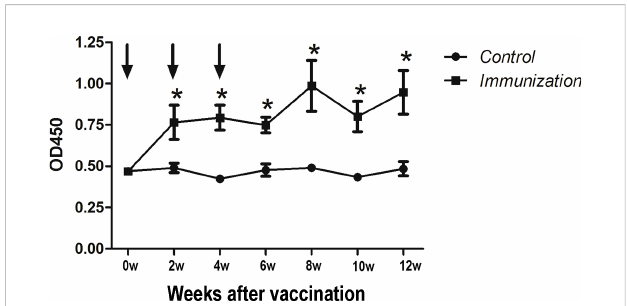
FIGURE 1 Mean (± SEM) of the serum antibody titers in the gonadotropin- releasing hormone (GnRH) immunization group (n = 35) and control group (n = 35). The ordinate is the OD of the serum GnRH antibody. The abscissa is the age of weeks after fi rst immunization and Arrows indicate the primary vaccination and subsequent boosters. * Indicates a signi fi cant difference ( P < cytometry. Figure 4A shows the gating strategy. Within 6 weeks after the fi rst immunization, the percentage of CD3+CD19- lymphocytes in the immunized group was signi fi cantly lower than that in the control group ( P < 0.05 ). Thereafter, over time, the percentage of CD3 +CD19- lymphocytes became similar between the immunized group and the control group ( P > 0.05). The total percentage of T lymphocytes gradually recovered, and then slightly increased (Figure 4B, upper left panel). The percentage of CD4+ lymphocytes in the immunized group was signi fi cantly higher than that in the control group ( P < 0.05, Figure 4B, upper right panel) from 4 to 6